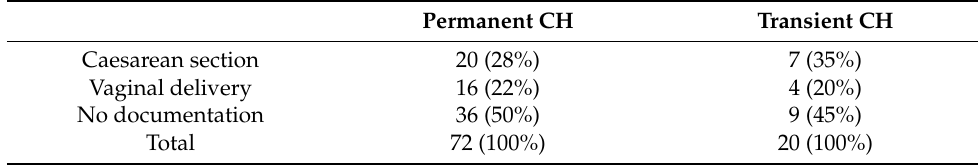
Table 8. Evaluation of delivery mode in babies with CH. [n